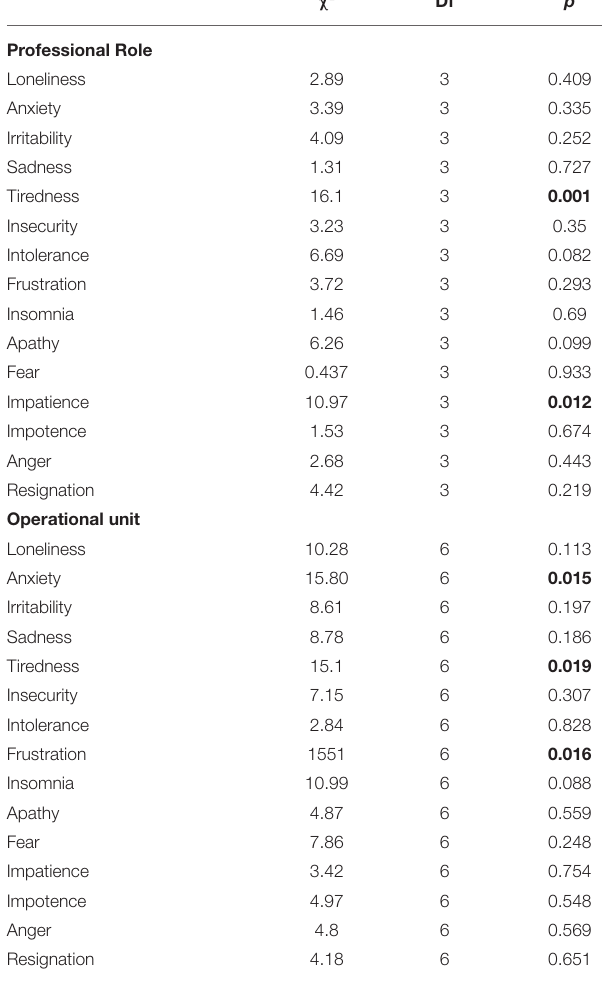
TABLE 5 | Multinomial logistic regressions omnibus Likelihood Ratio tests for psychological impact category encompassing negative feelings and demographic factors (gender, age, geographical region, professional role, operational unit).